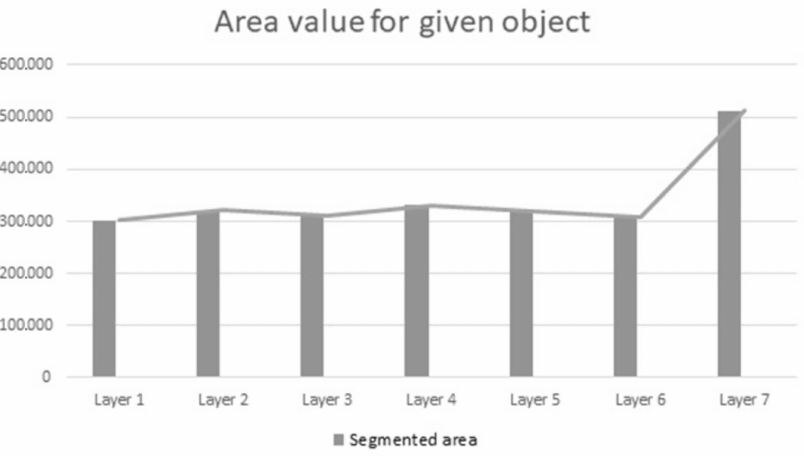
Figure 14. Visualization of the changes in the area during the progression of consecutive layers. For each of the objects, the center of the mass has been determined, and every con- secutive layer was checked to view what object is present in the next layer with